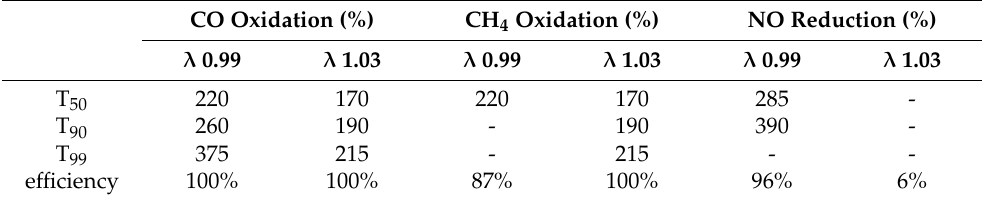
CO, CH 4 , NO at rich-burn ( λ = 0.99) and lean-burn conditions ( λ = 1.03).